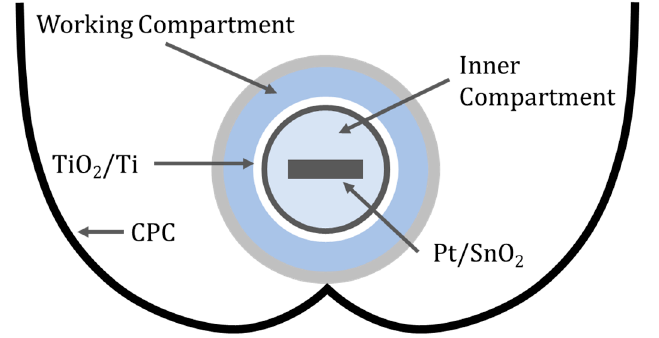
Figure 12. Schematic of the two-compartment reactor with a CPC.